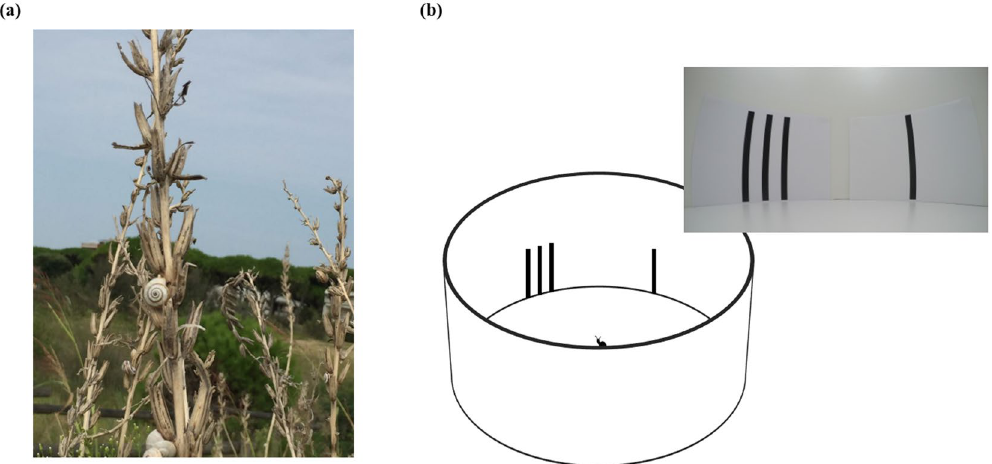
Figure 1. ( a ) Example of a dune snail T. pisana climbing on the stem of tall vegetation. ( b ) The circular arena used for investigating quantity discrimination ability in